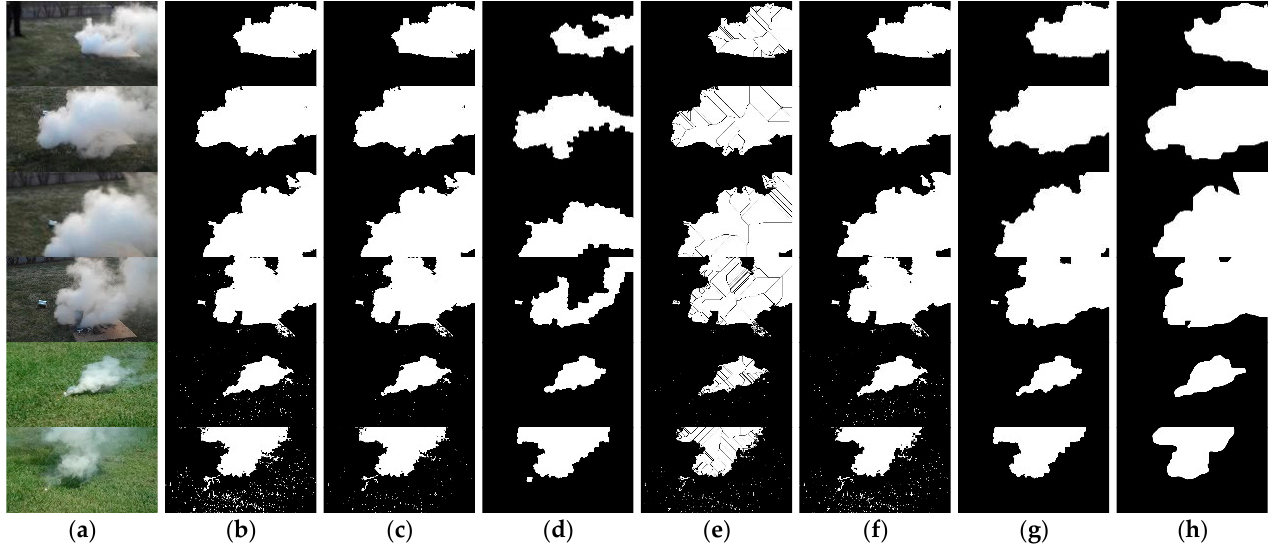
Figure 6. Segmentation results of different algorithms. ( a ) Original image; ( b ) FCM;( c ) K- means; ( d ) DPC; ( e ) Watershed; ( f ) MIT; ( g ) TSDPC; ( h ) Manually labeled image.